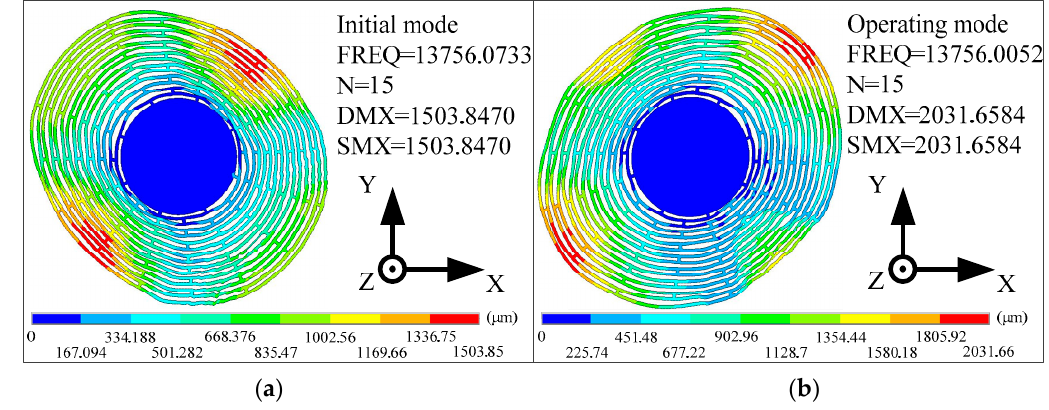
Figure 4. The initial modes ( a ) and the operating modes ( b ) of the sample resonator.